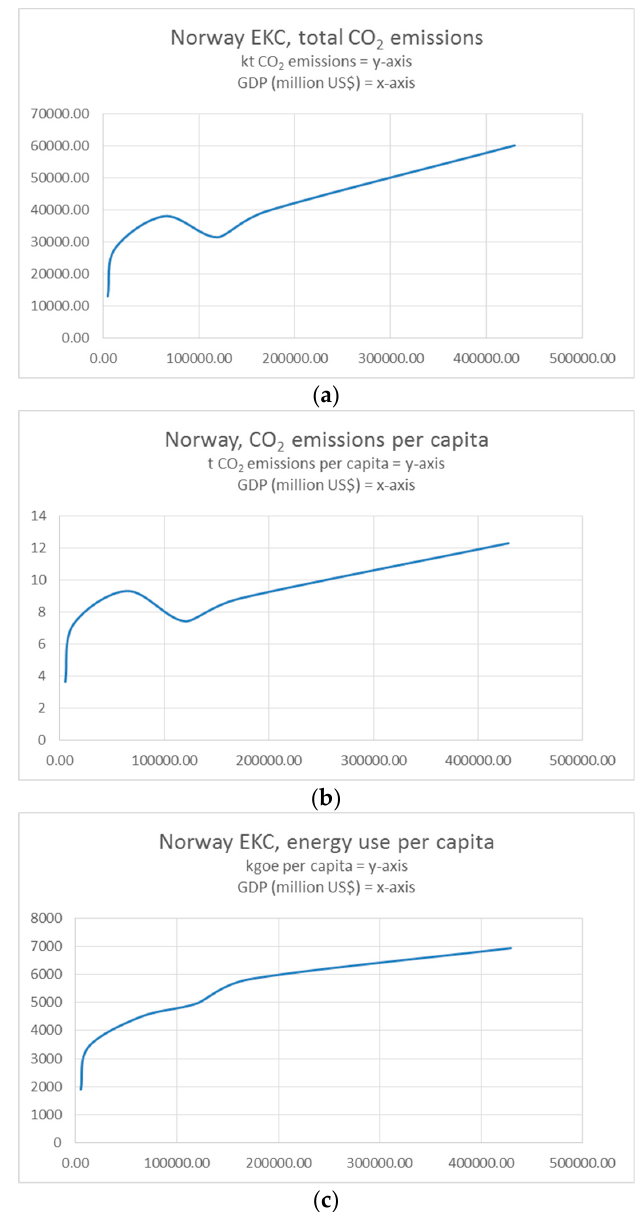
Figure 8. Analysis of the EKC for Norway. Data source: [44]. ( a ) Norway EKC, total CO 2 emissions; ( b ) Norway EKC, CO 2 emissions per capita; ( c ) Norway EKC, energy use per capita.